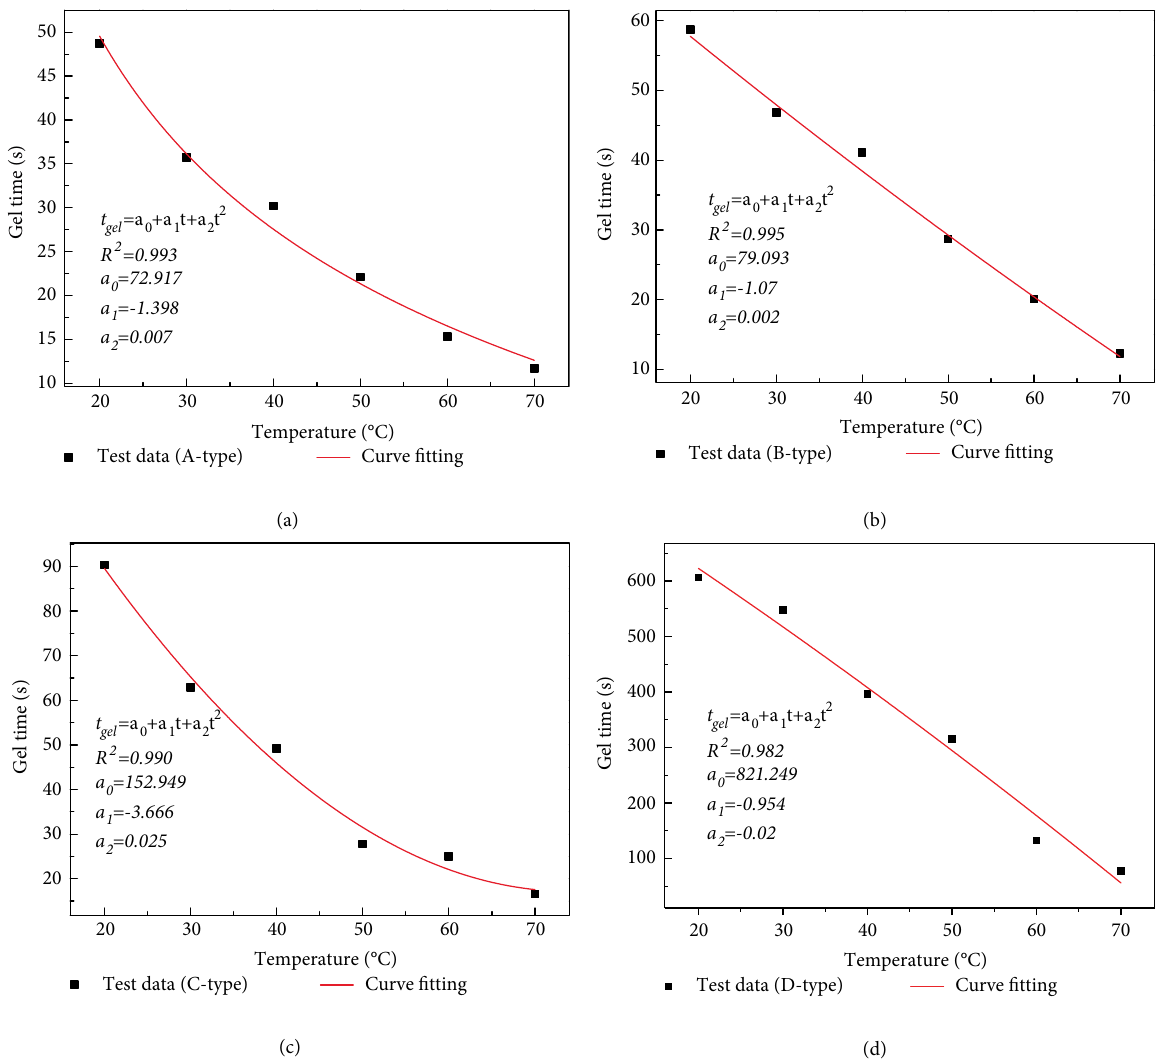
Figure 13: The regression function curve of the relationship between gelation time and temperature: (a) A-type, (b) B-type, (c) C-type, and (d)